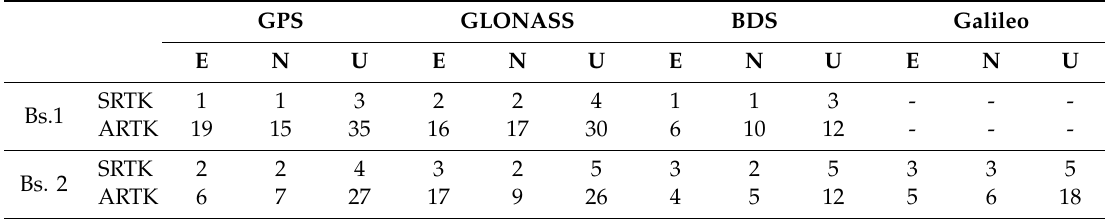
Figure 3. RTK position errors resulting from synchronous ( top ) and asynchronous ( bottom ) data in Session A1 for Bs.2. Table 5. The root mean square (RMS) errors (mm) of SRTK and ARTK solutions for Bs.1 and 2.